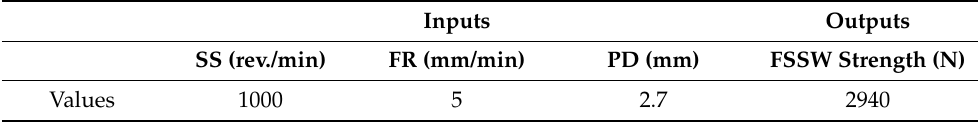
Figure 13. Three-dimensional surface result of FSSW fuzzy system. Table 9. Output results of FSSW fuzzy system.